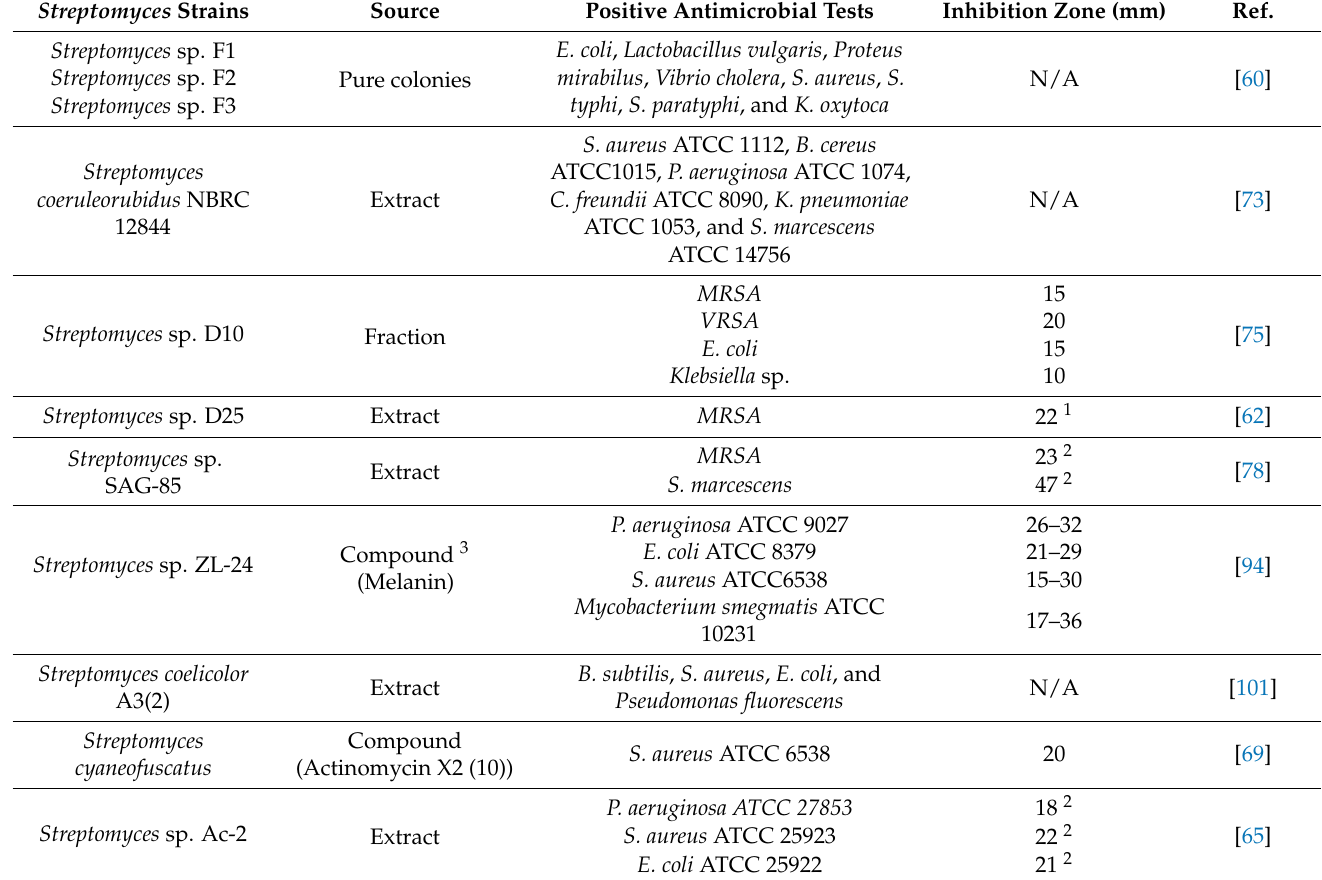
Table 5. Streptomyces strains with antimicrobial